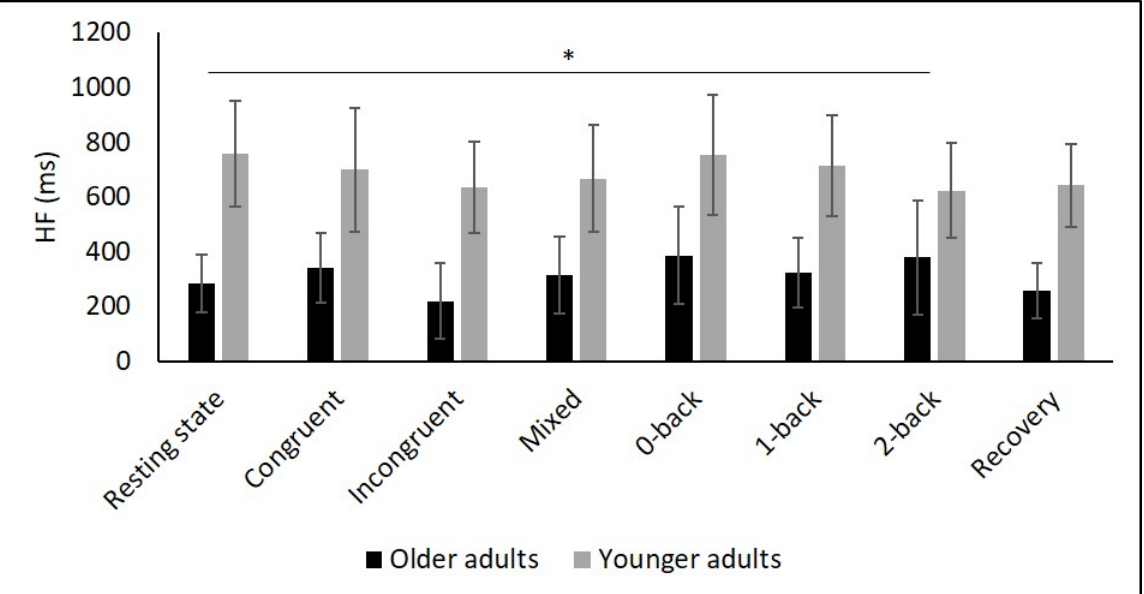
Figure 5. Means and group × condition interactions for HF. Error bars indicate ±2 standard error of mean; abbreviations: HF: high frequency; ms: milliseconds. * p < 0.05.